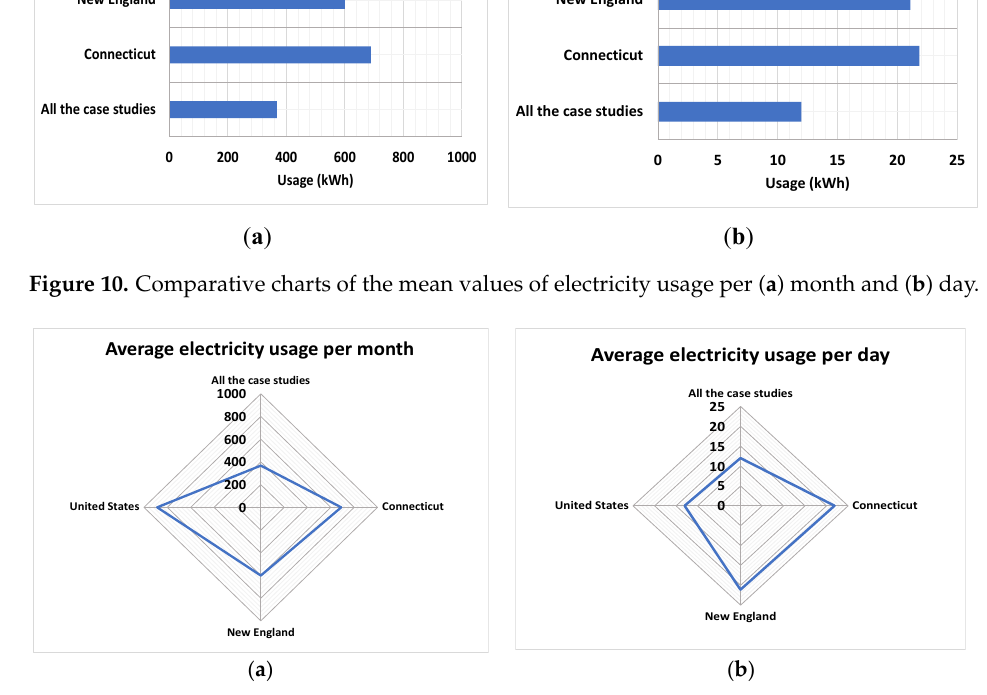
Figure 11. Links between the mean values of electricity usage per ( a ) month and ( b ) day in the case studies and other locations.